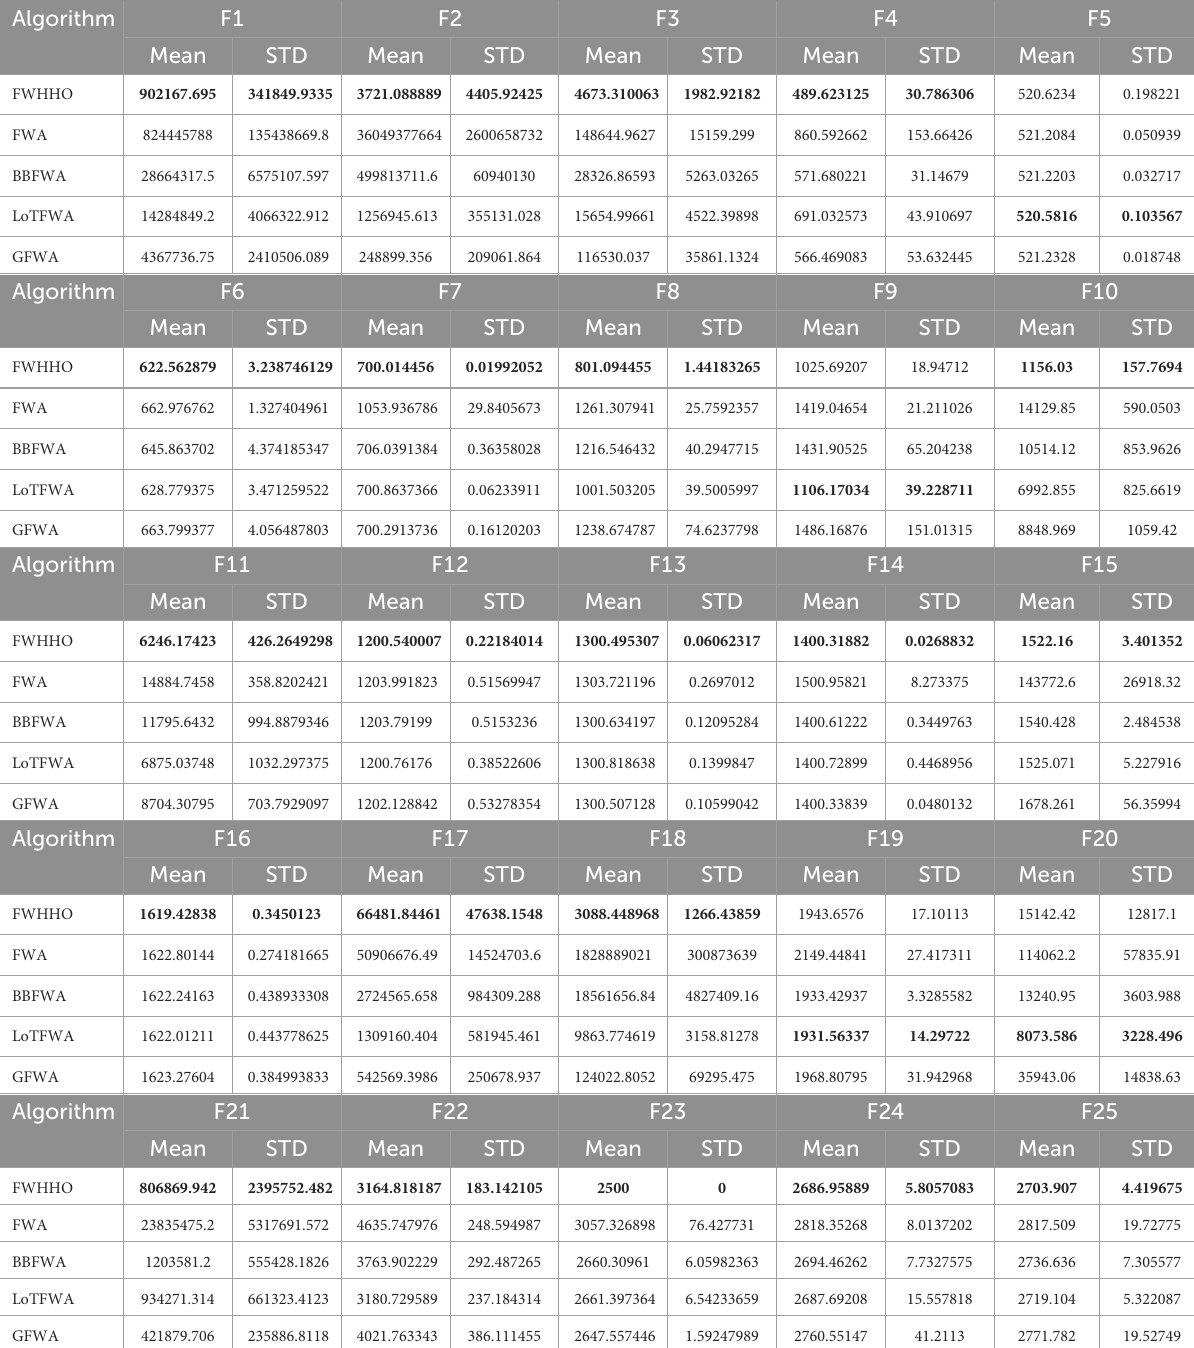
TABLE 6 Comparison of FWHHO and fireworks